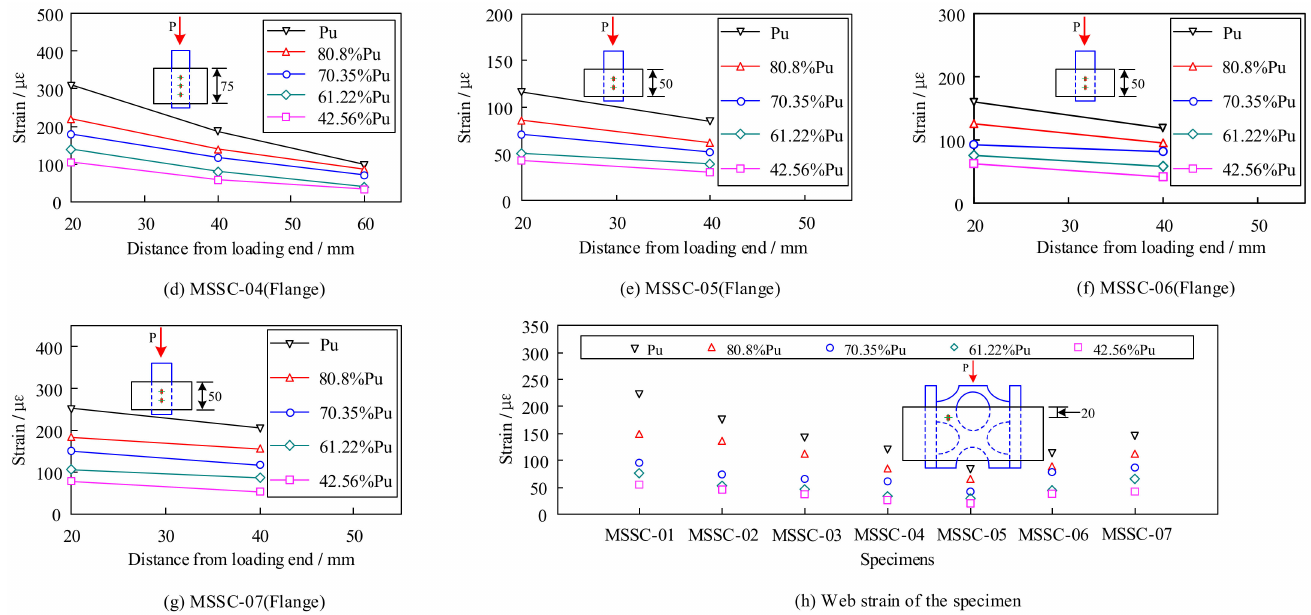
Figure 11. Longitudinal strain distribution at each position of MSSC specimens in the rising section of the